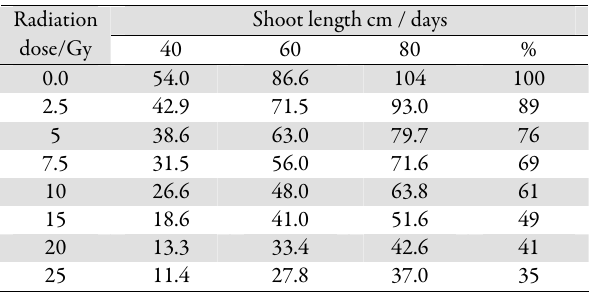
Table 2. Effect of gamma irradiation on in vivo Nicotiana alata haploid plants